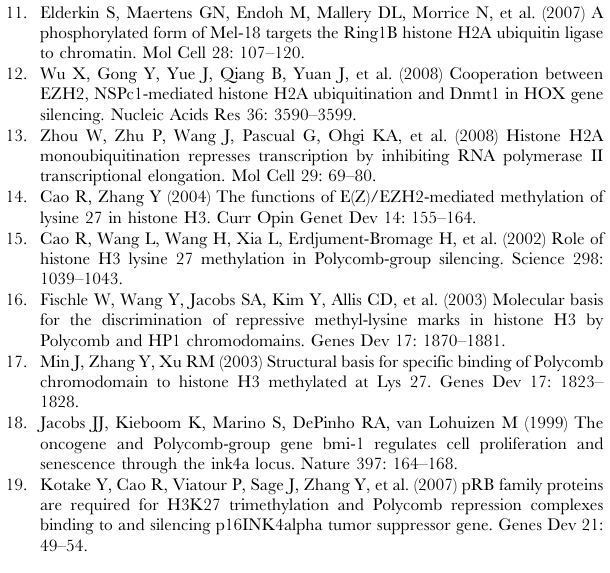
Figure S1 Genic peak distribution analysis reveals peak number enrichment towards the transcription termination site of genes and